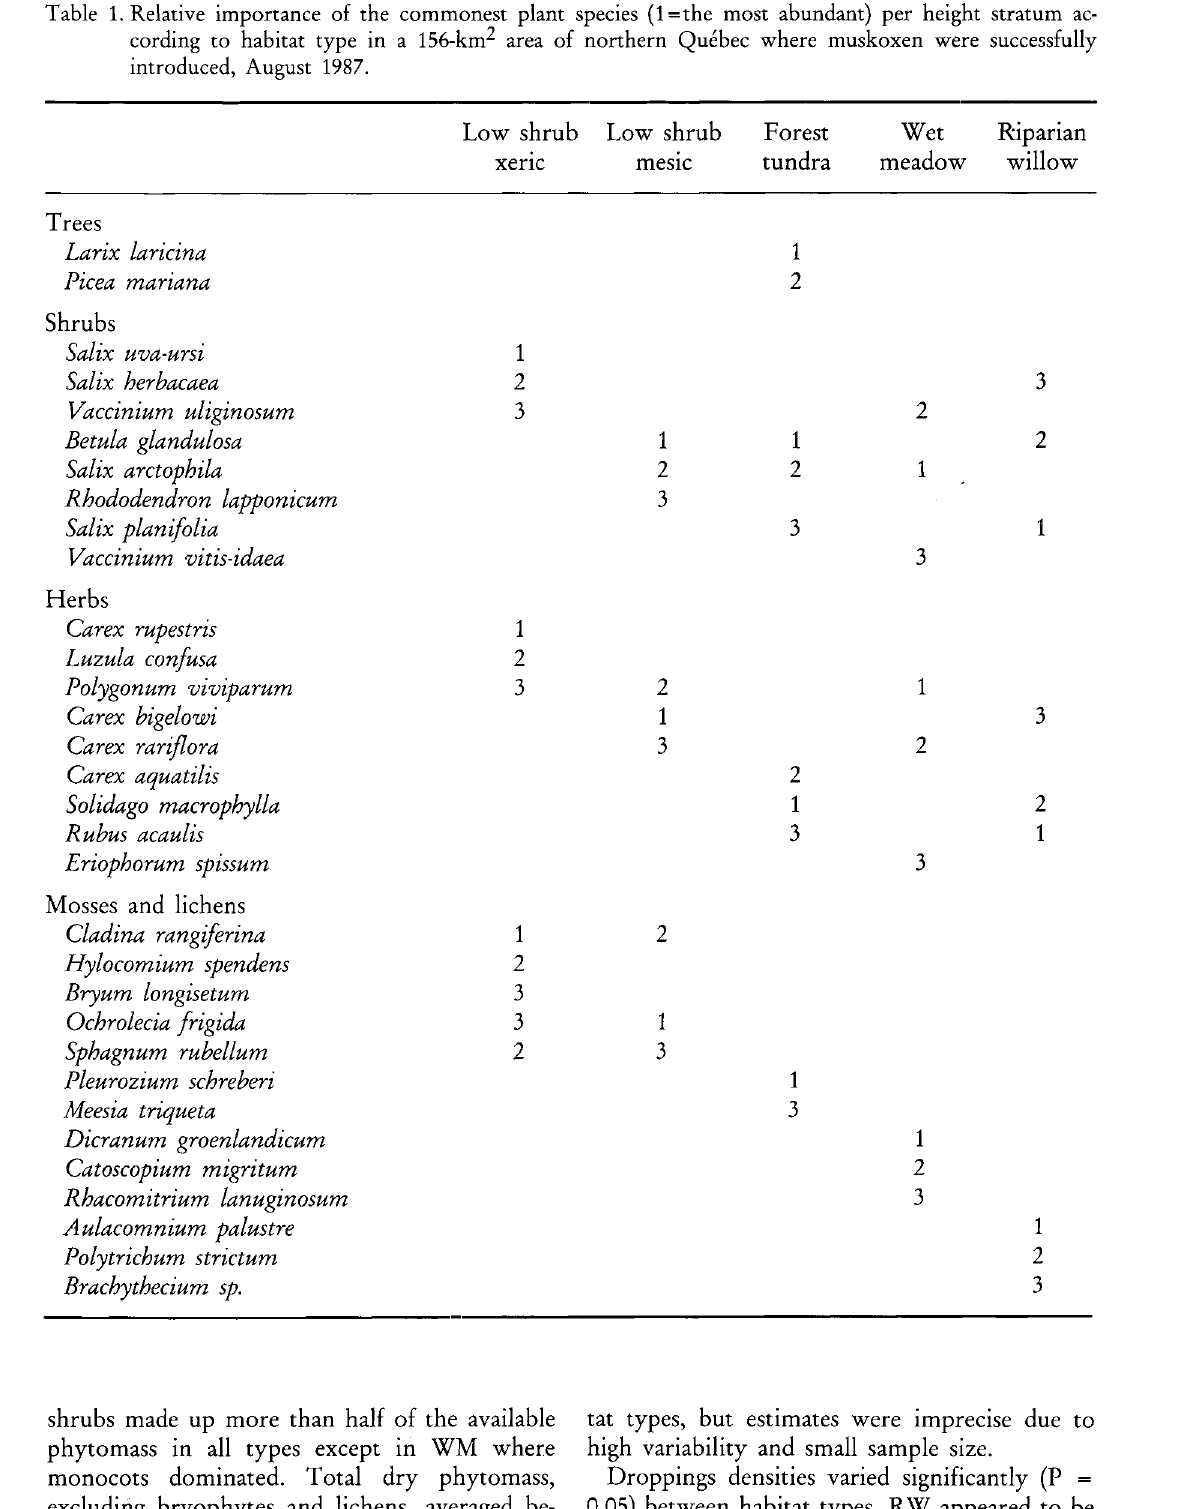
Table 1. Relative importance of the commonest plant species (l=the most abundant) per height stratum ac cording to habitat type in a 156-km 2 area of northern Quebec where muskoxen were successfully introduced, August